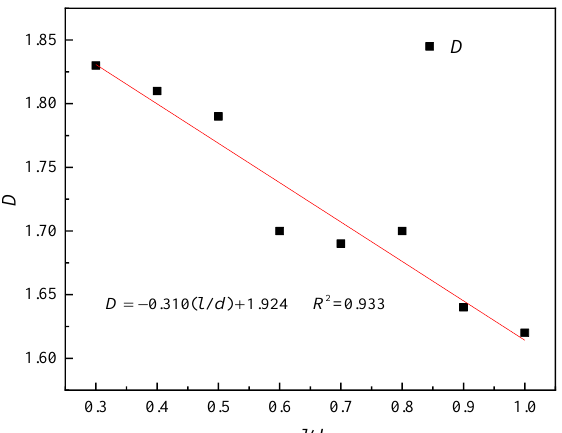
Figure 11. lg ( M L eq / M ) — lg L eq curve of fractal dimension of specimens with different l / d .